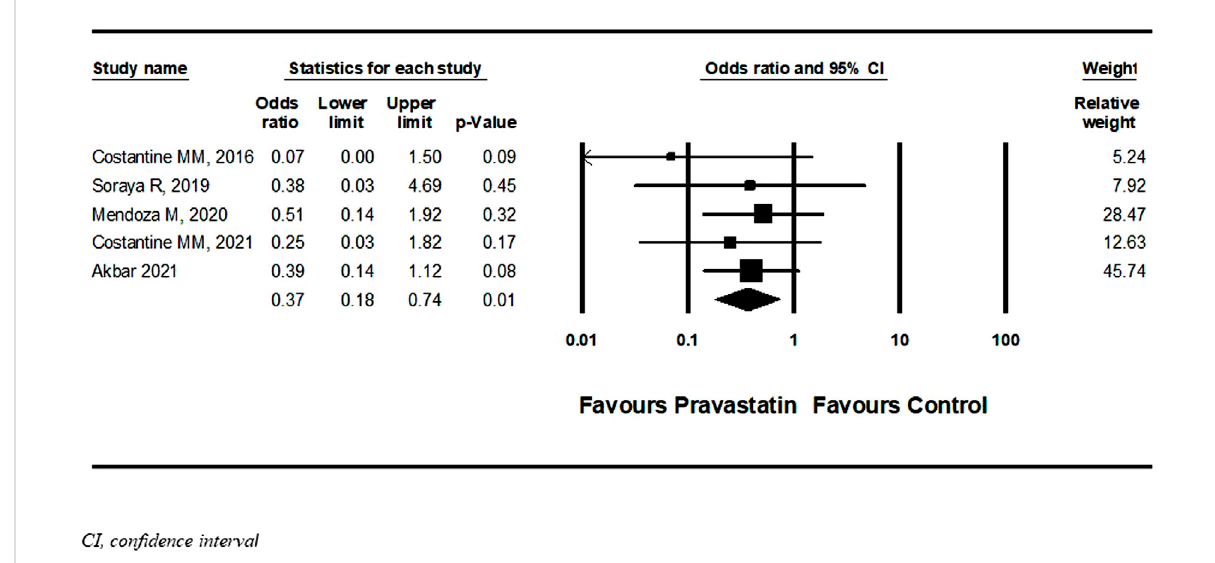
FIGURE 7 Sensitivity meta-analysis of the association of pravastatin treatment with new diagnoses of